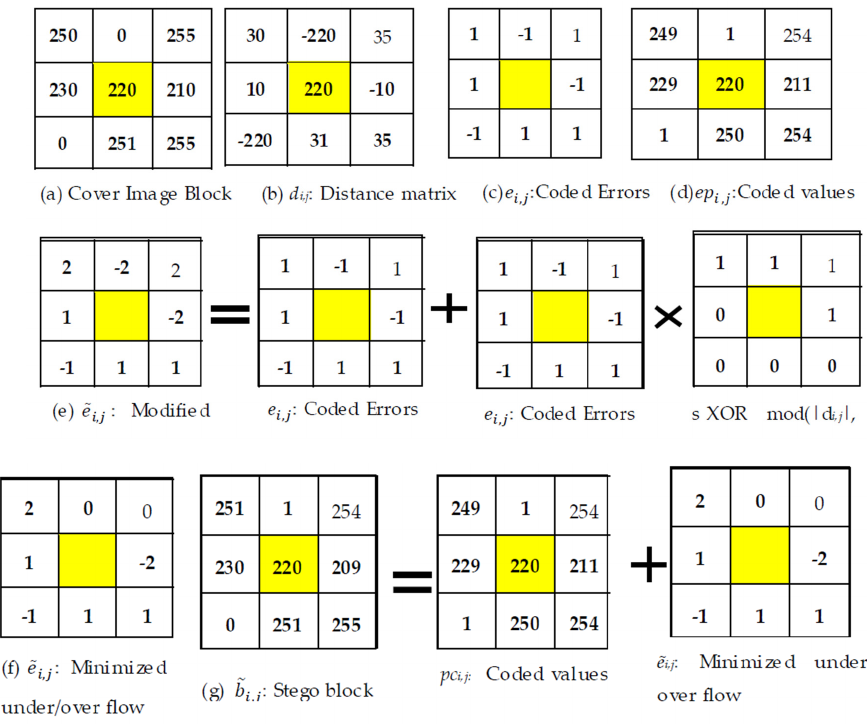
Figure 2. The complete message-embedding procedure.